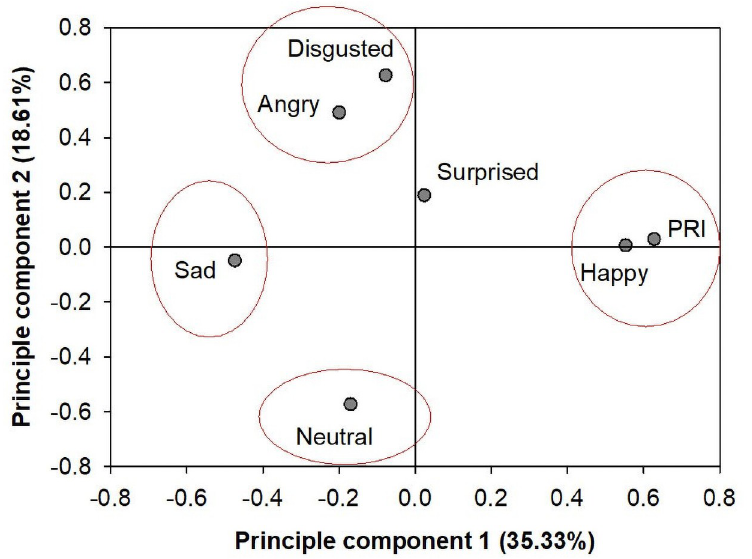
Fig 6. Eigenvalues of happy, sad, neutral, angry, disgusted, and surprised expression scores and positive response index (PRI) in the first two principle components.